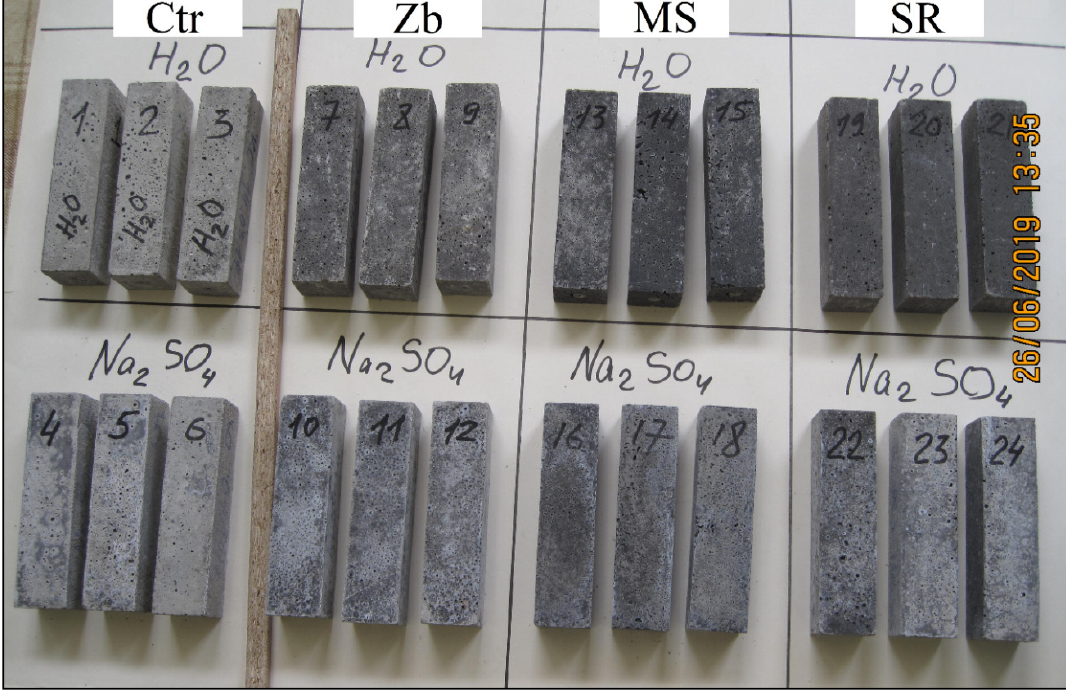
Figure 7. Photo of samples after 340 days in water and in Na 2 SO 4 solution.